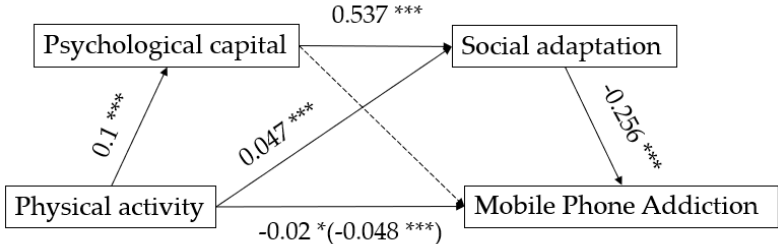
Figure 1. Mediation model of psychological capital and social adaptation between physical activity